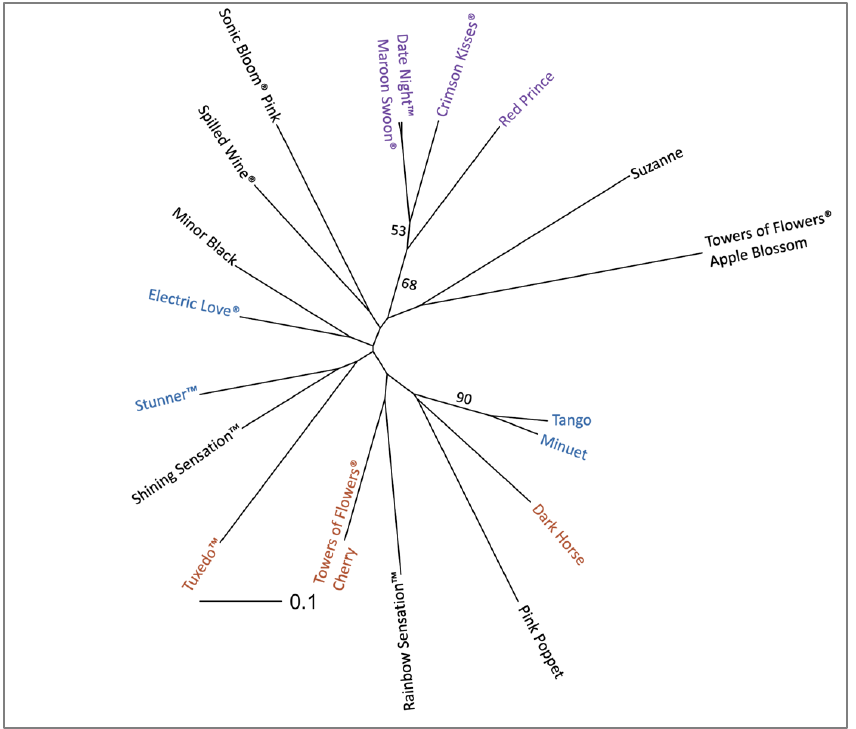
Figure 5. Unrooted neighbor joining tree based on Bruvo’s distance and the BIONJ algorithm across 18 Weigela cultivars using 1000 bootstrap replicates. Internal branches with bootstrap values greater